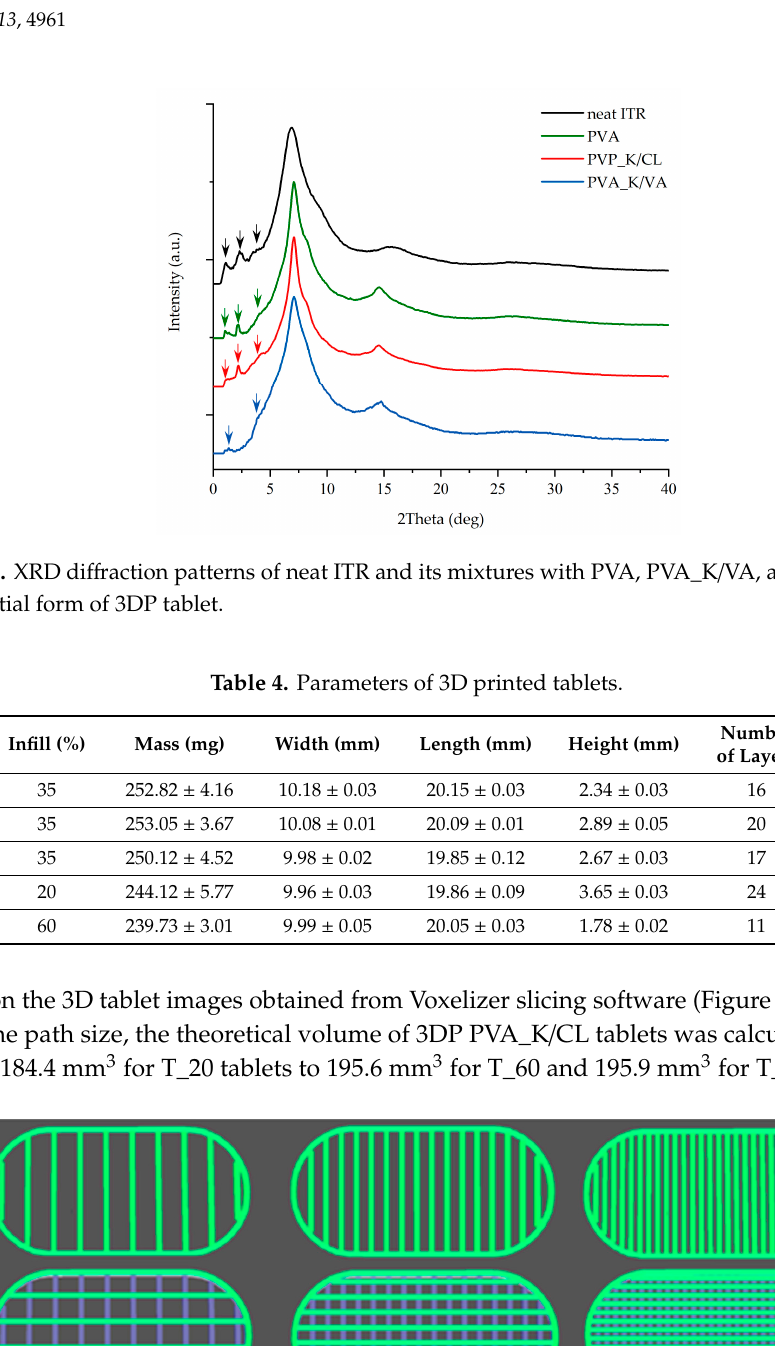
Figure 5. Images of PVA_K/CL tablet layers obtained from Voxelizer software.